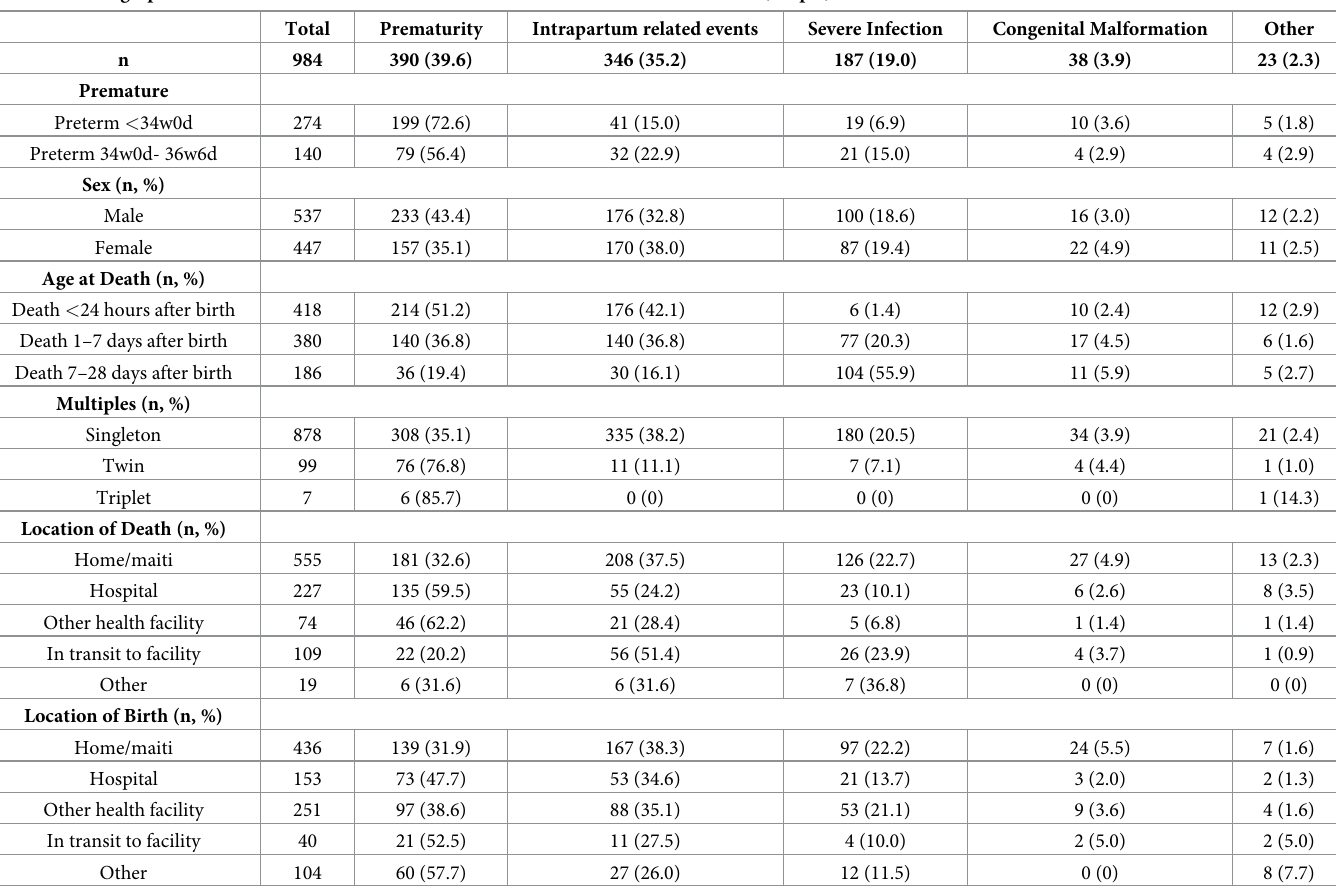
Table 1. Demographic and clinical characteristics for each cause of neonatal deaths in Sarlahi, Nepal,